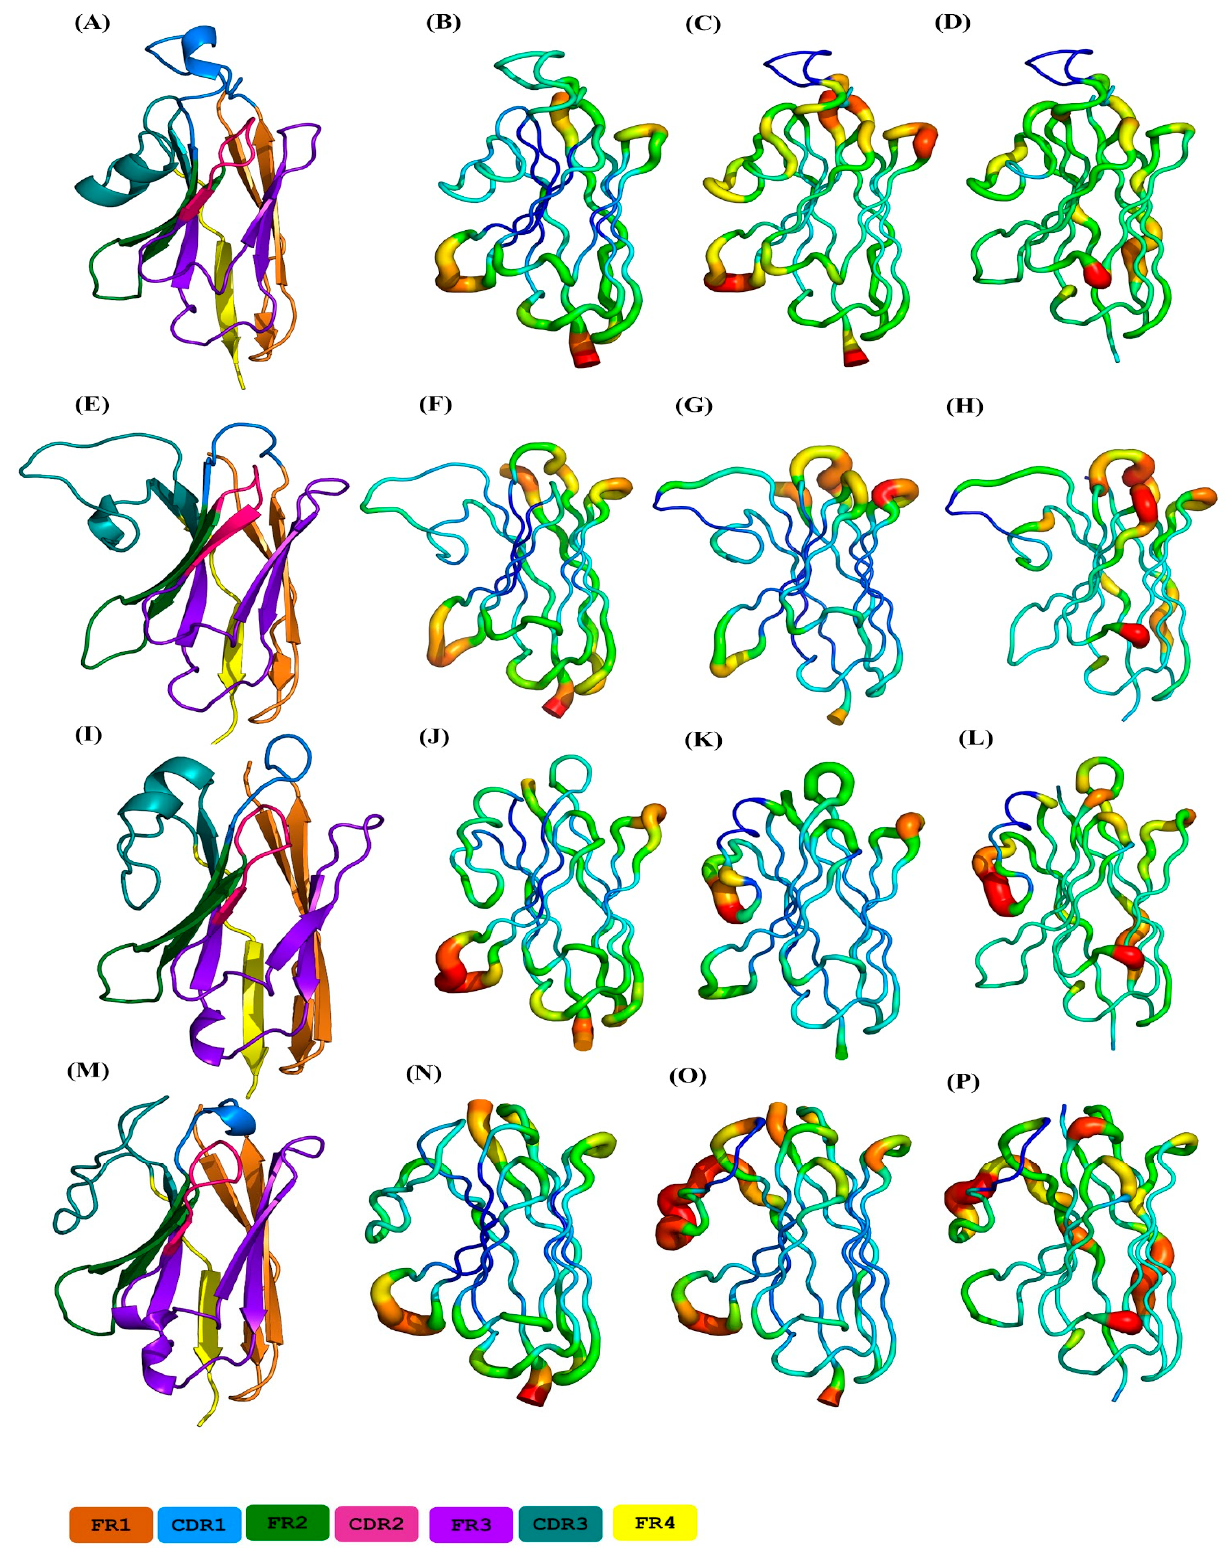
Figure 6. Representation of mean values of flexibility metrics onto a 3D structure of a V H H from each cluster. ( A – D ) RMSF cluster1, ( E – H ) RMSF cluster 2, ( I – L ) RMSF cluster 3, ( M – P ) and RMSF cluster 4, with ( A , E , I , M ) are coloured coded FRs and CDRs, ( B , F , J , N ) mean normalised C α B-factors, ( C , G , K , O ) mean C α RMSF values, and ( D , H , L , P ) mean N eq values.